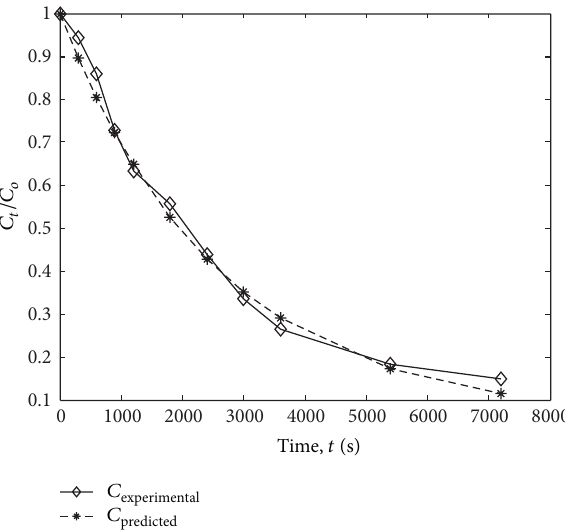
Figure 17: Variation of dimensionless bulk concentration of MB with time for initial bulk concentration of 50 mg/L.